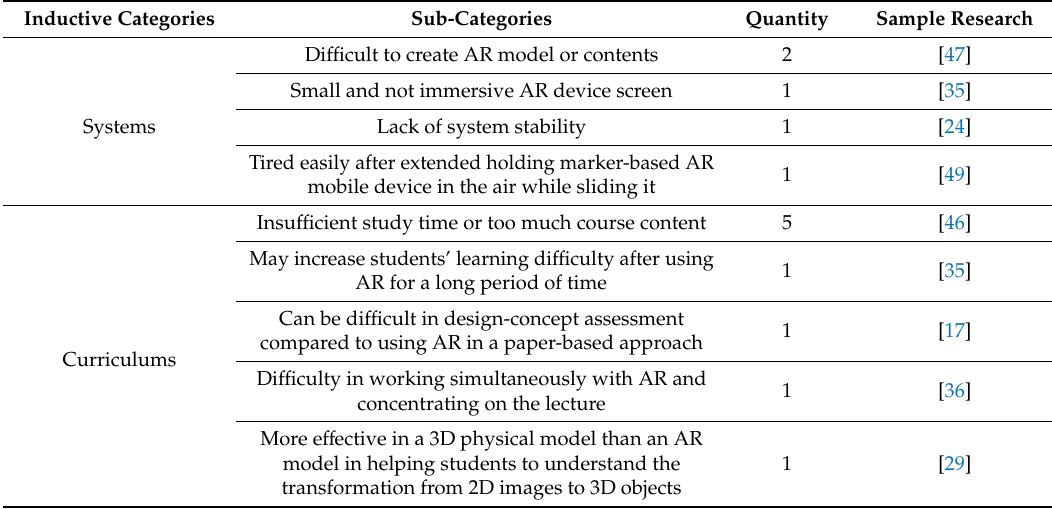
Table 4. AR challenges in ACE